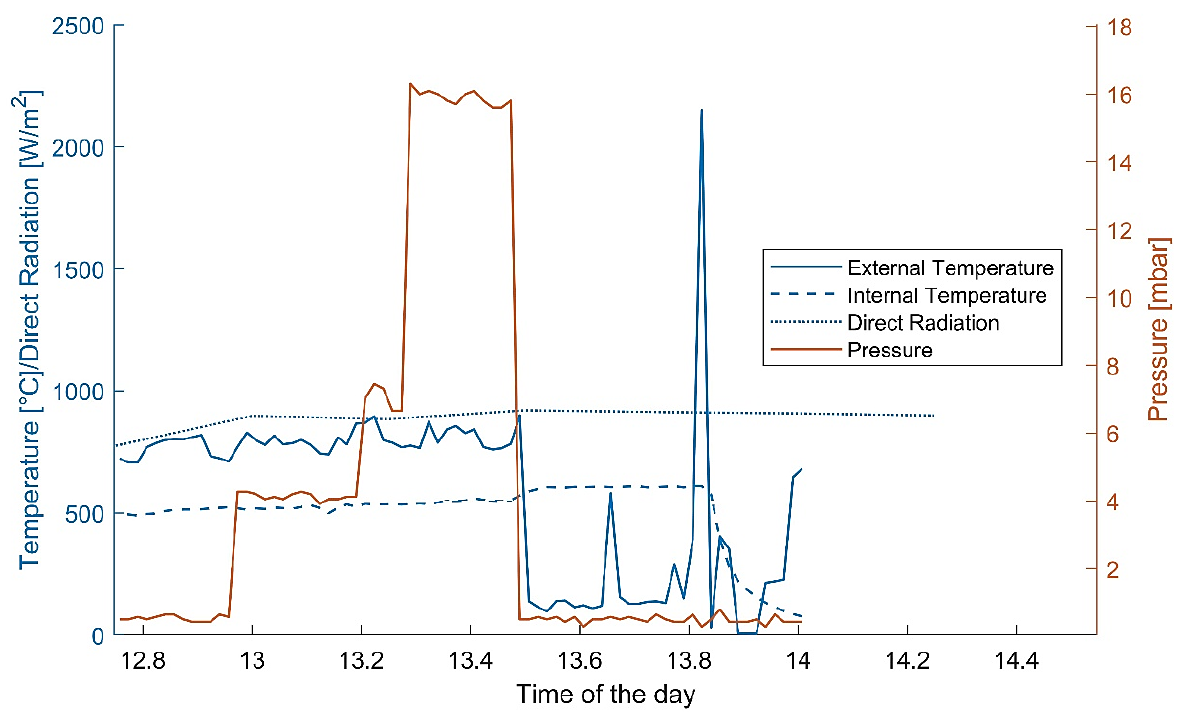
Figure 2. Internal and external temperature, direct radiation on the normal plane and pressure recorded during test #3.